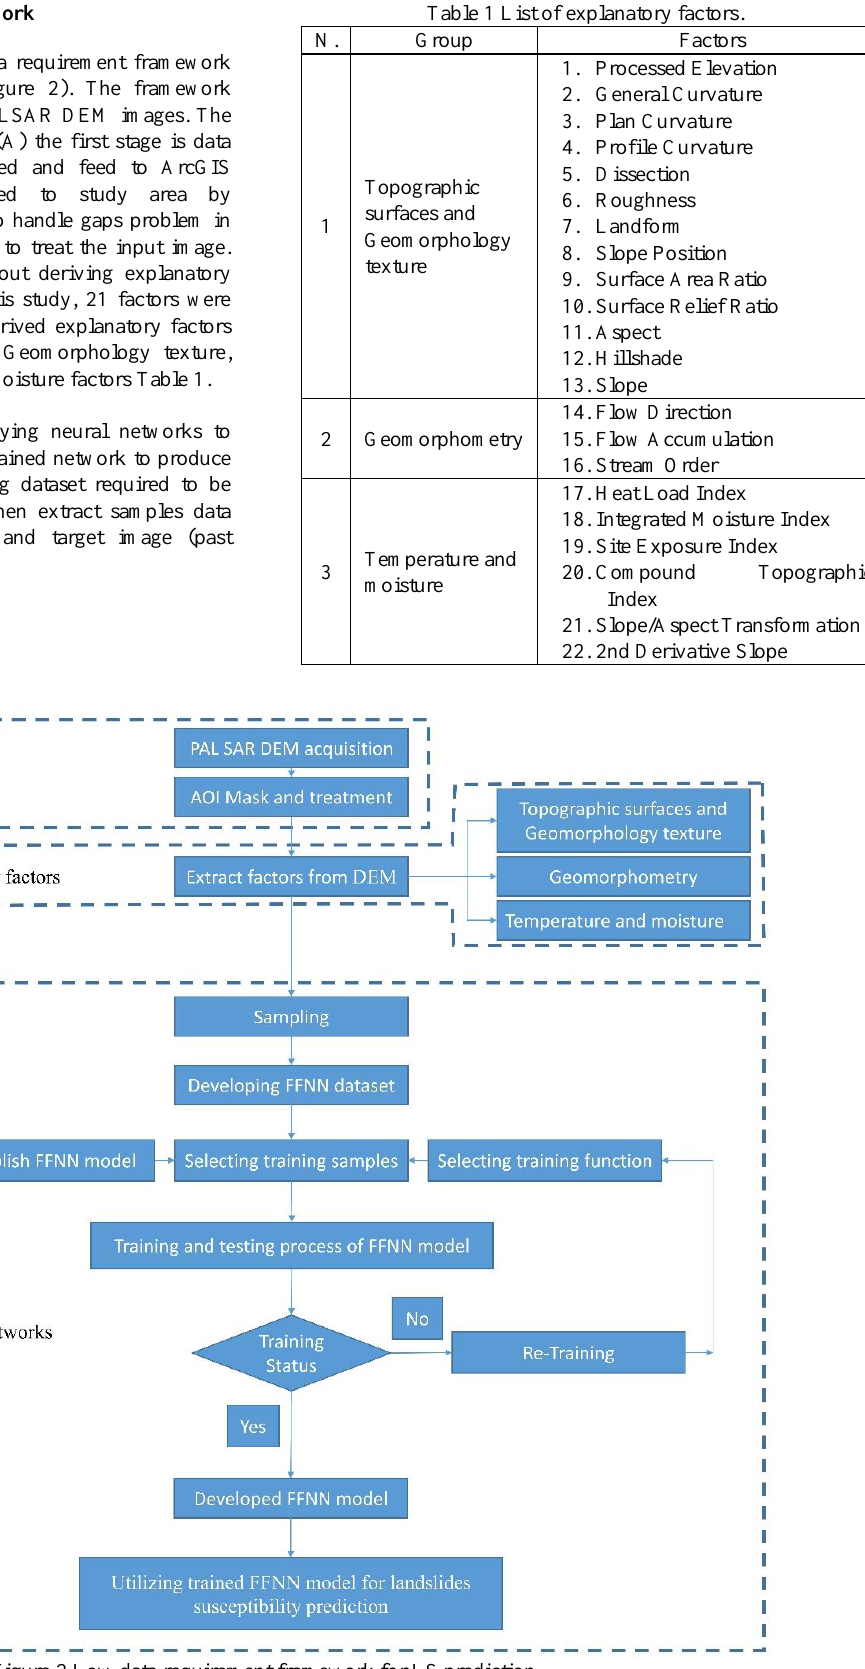
Figure 2 Low data requirement framework for LS